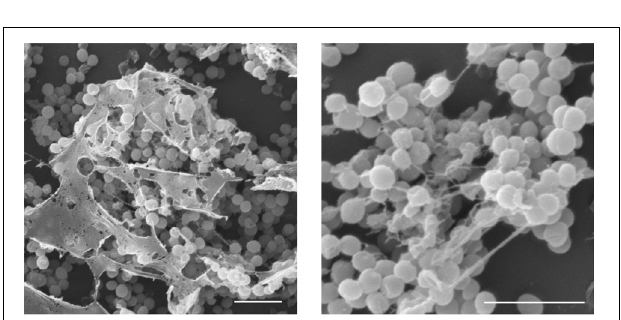
FIGURE 8 | Bacterially triggered assembly of Cg -BigDef1 into nanonets. Large and branched fibers entrapping Staphylococcus aureus are observed by scanning electron microscopy when S. aureus SG4511 is exposed to Cg -BigDef1. The same observations are made with S. aureus exposed to the N-terminal domain alone (21). Bars represent 3 µ